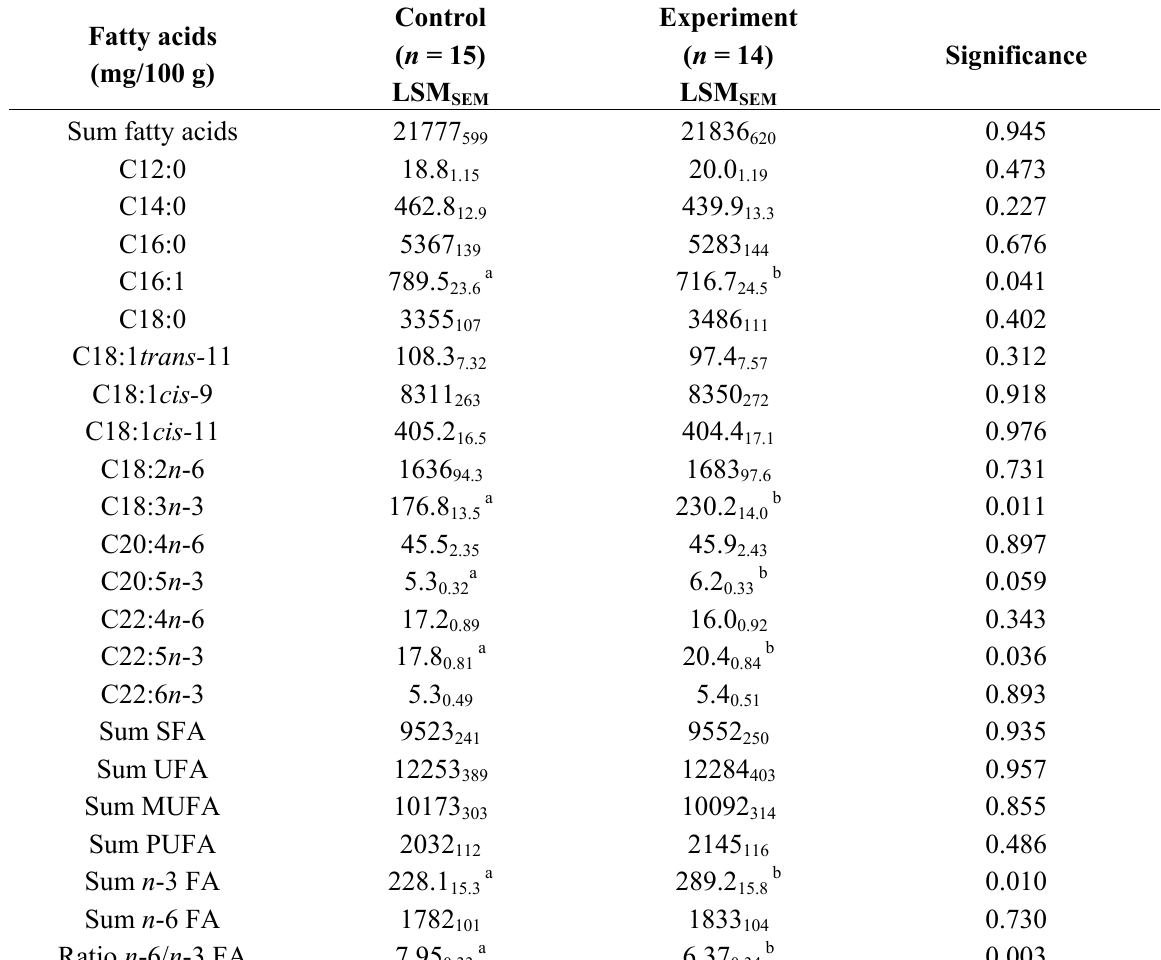
Table 3. Fatty acid concentration (mg/100 g) of tea sausages spread produced from meat sections of German Holstein bulls fed a different